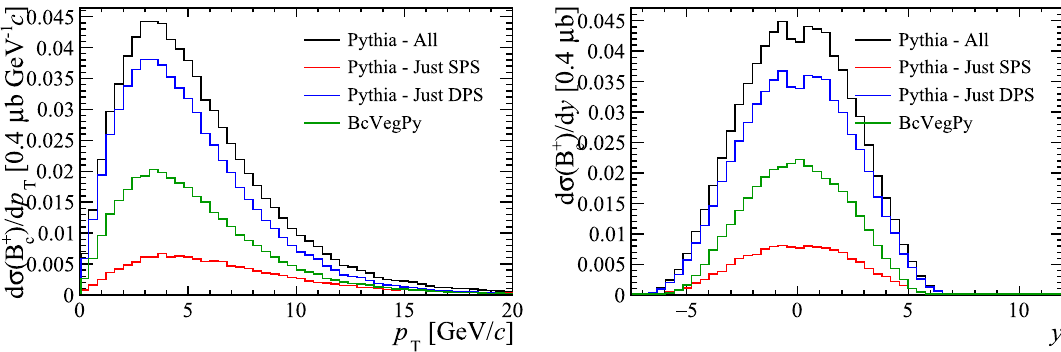
Fig. 9 Kinematic distributions of B + c mesons generated with BcVegPy and